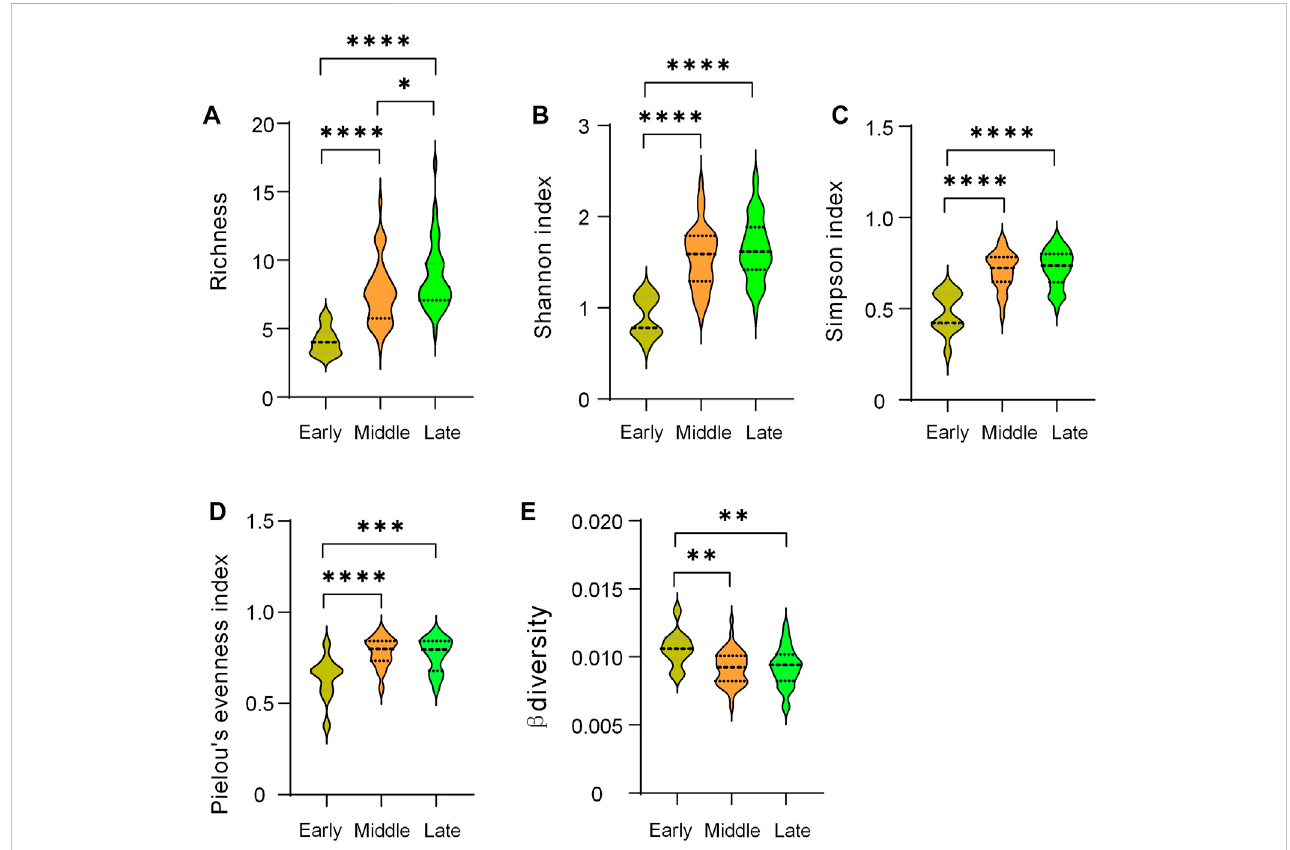
FIGURE 6 Comparison of biodiversity indices at different restoration stages. *, p < 0.05; **, p < 0.01; ***, p < 0.001; ****, p <